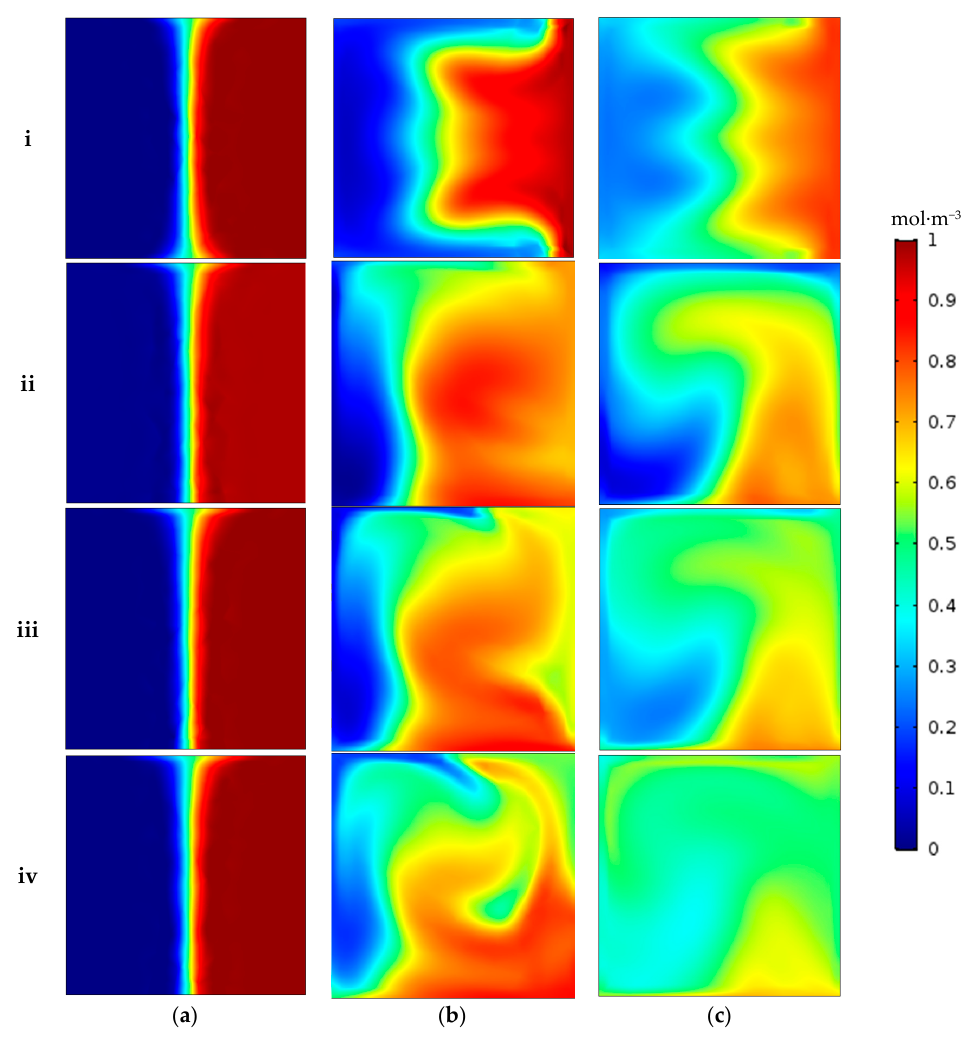
Figure 6. Concentration contours at Reynolds number of 50 at three planes (shown in Figure 1): ( a ) A–A; ( b ) B–B; and ( c ) C–C; for ( i ) Case 1; ( ii ) Case 2; ( iii ) Case 3; and ( iv ) Case 4.